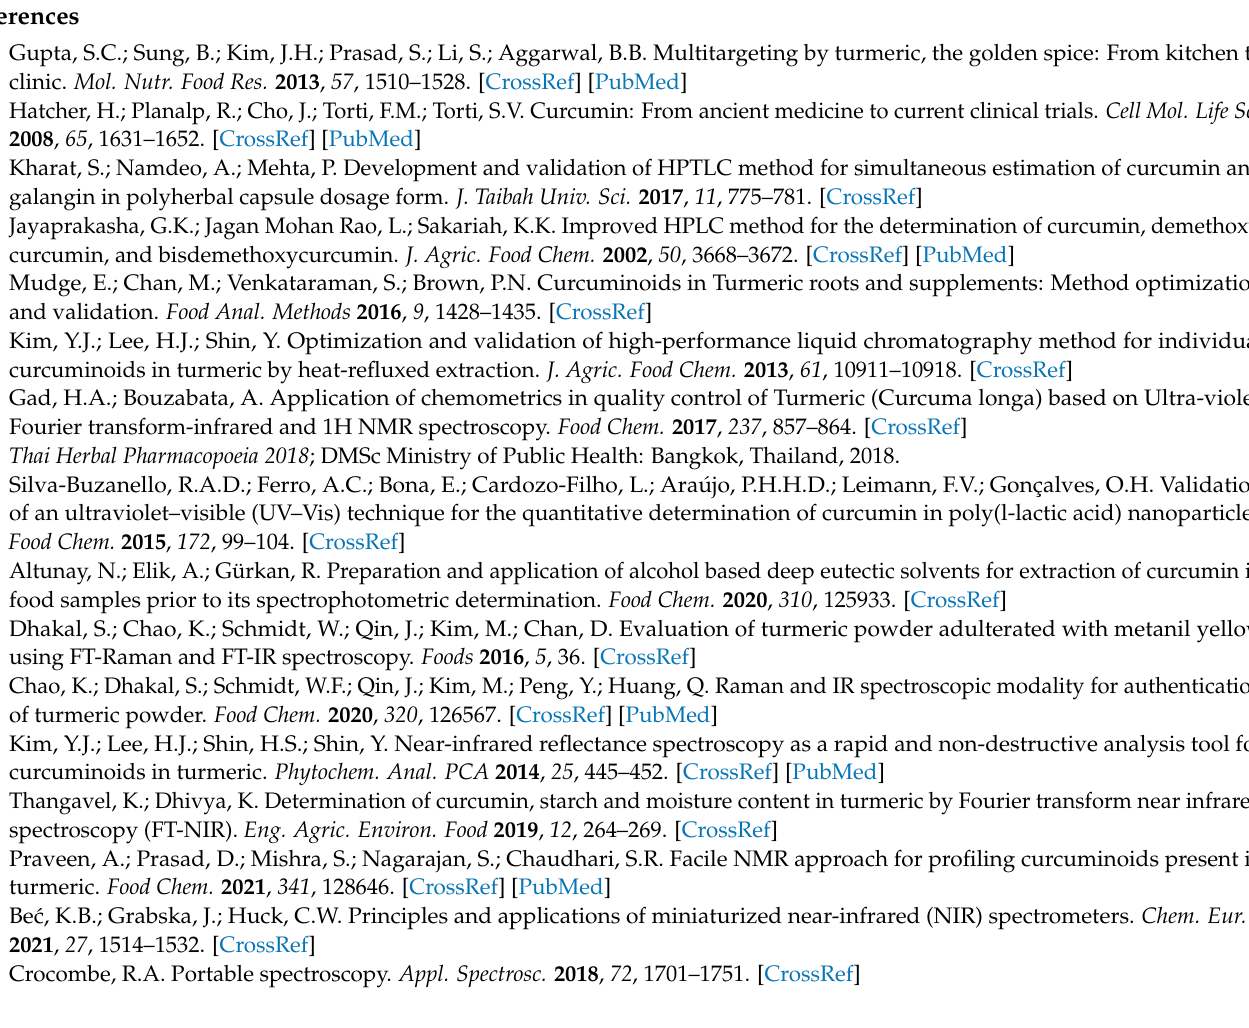
Figure S1: The calibration and prediction factor plots of the optimum PLSR